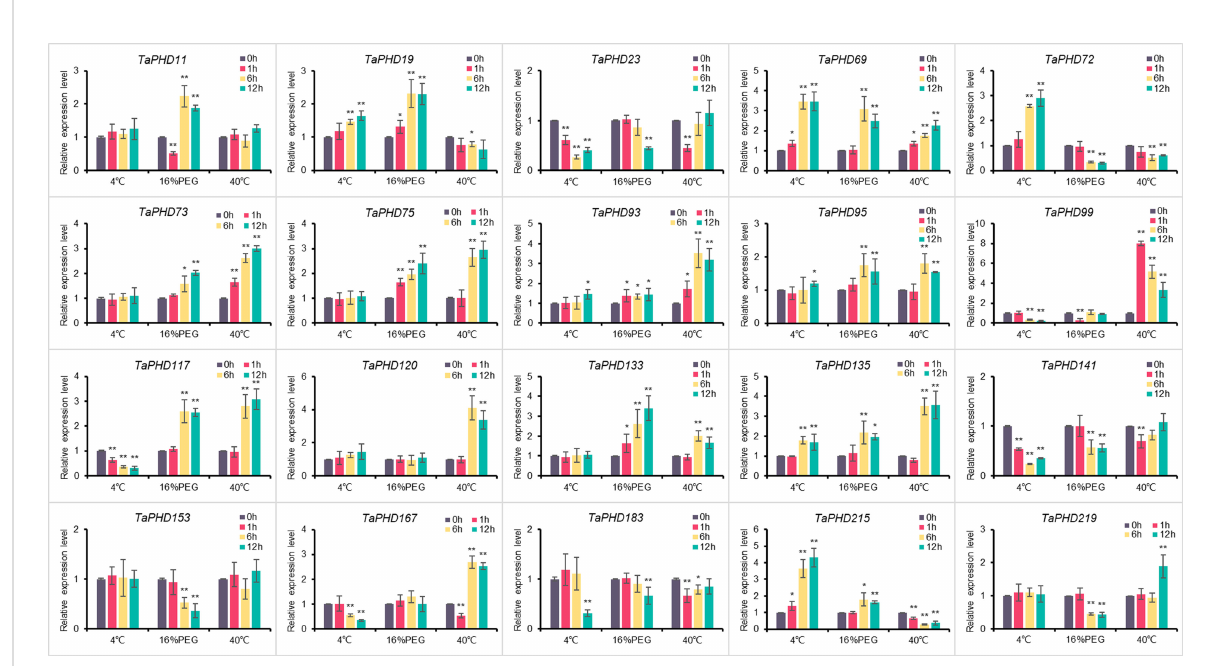
FIGURE 11 Relative expression levels of 20 genes under three different treatments. Expression of TaPHD genes in wheat were detected after 4°C, 16% PEG, and 40°C treatments for 0, 1, 6, and 12 h. Signi fi cant differences were determined by one-way ANOVA test: * p < 0.05; ** p <